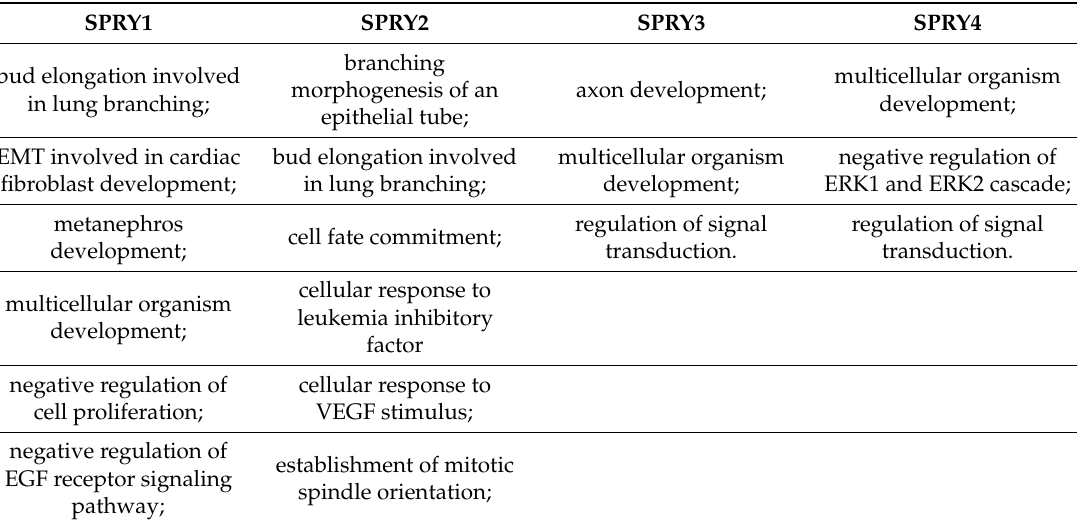
Table 1. List of known Sprouty protein (SPRY) functions in biological